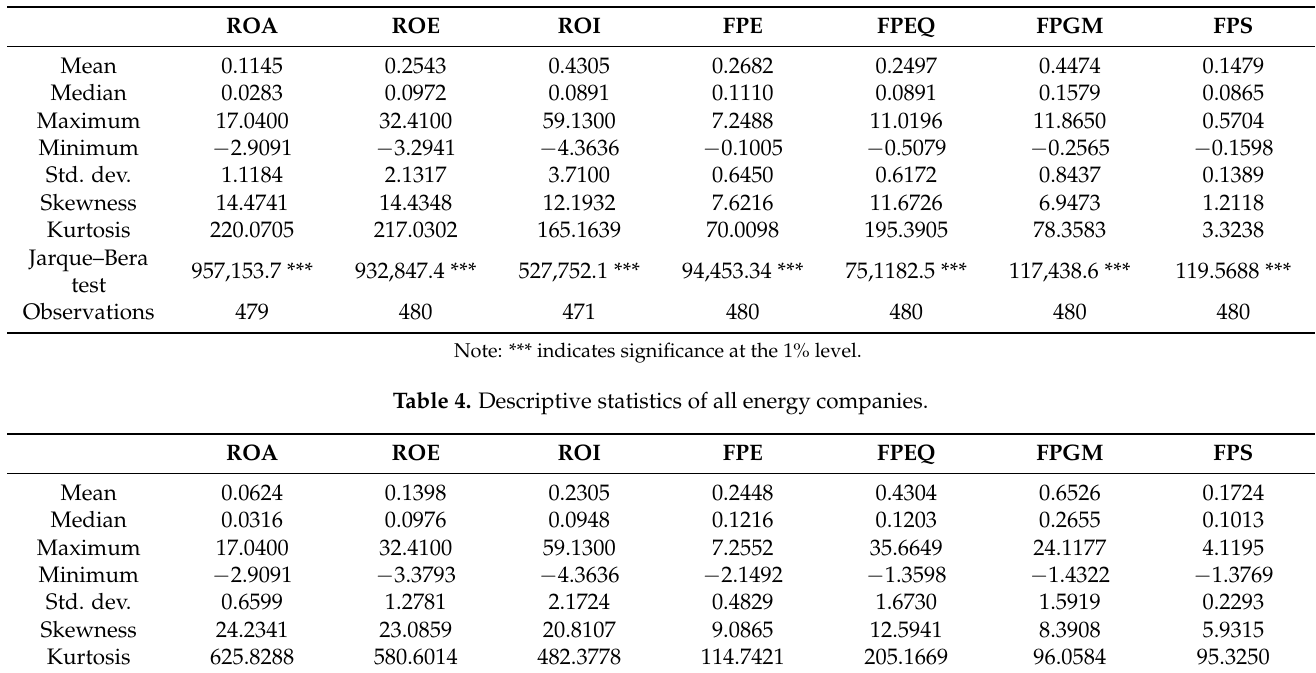
Table 3. Descriptive statistics for electricity companies.